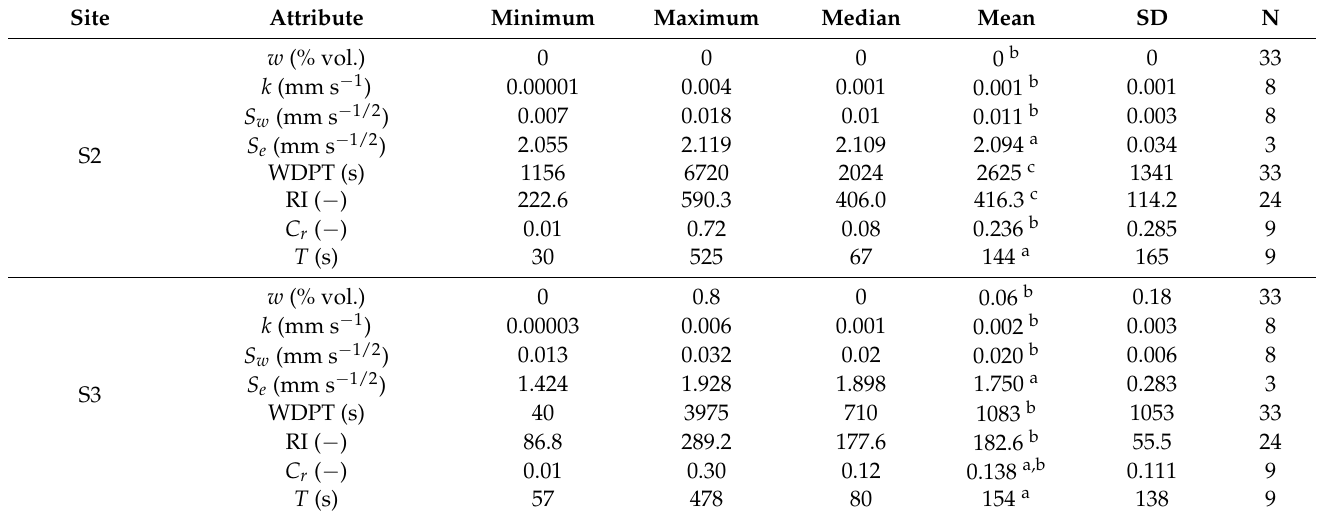
Properties denoted with different letters are significantly different on significance level 0.05.